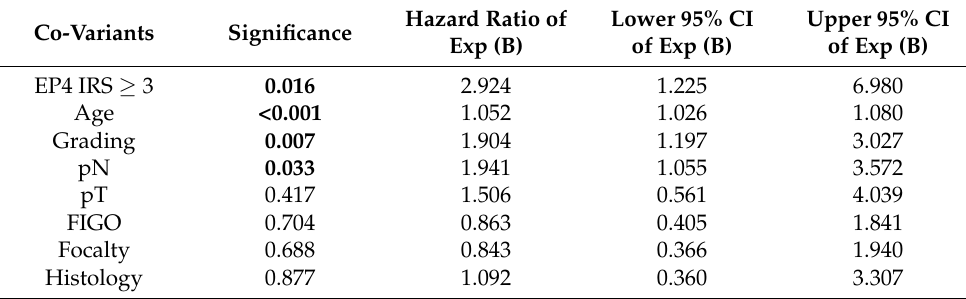
Table 2. Cox regression of clinicopathological variables regarding overall survival.